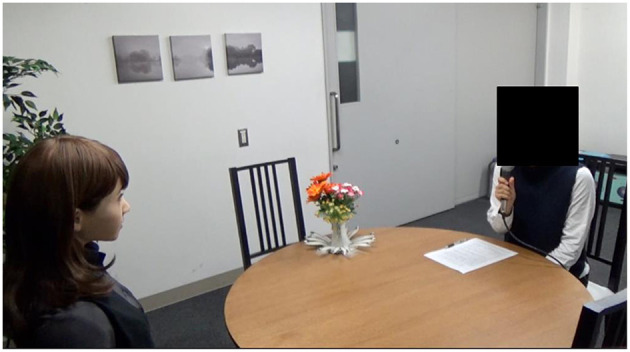
Experimental scene.